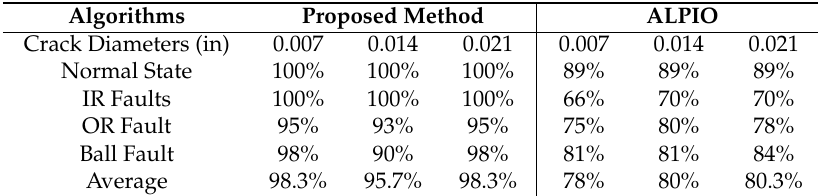
Table 4. Fault diagnosis results for Dataset 2 for the proposed method and ALPIO when torque load = 1 hp. Algorithms